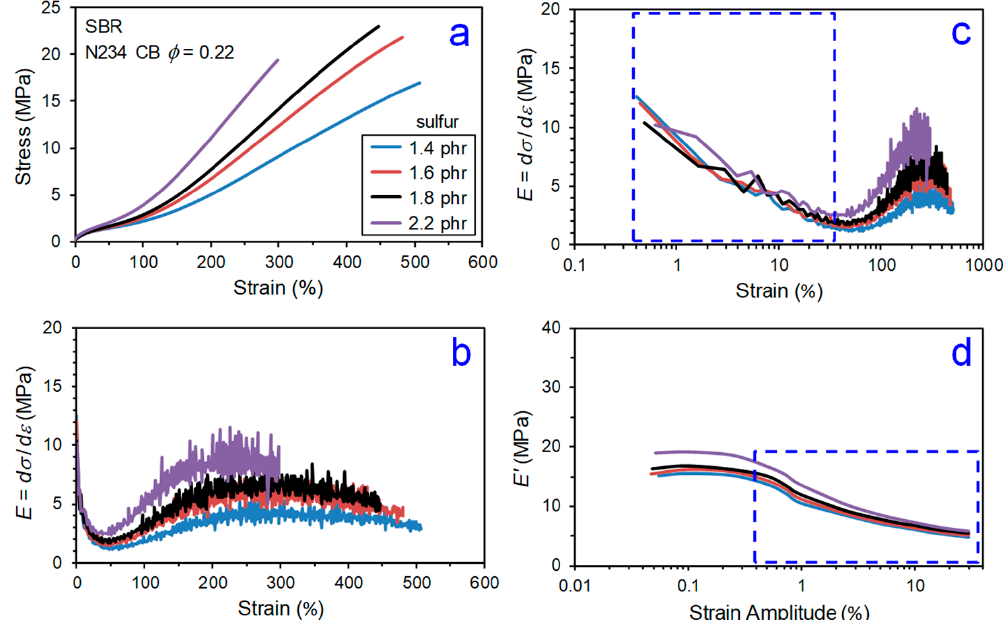
Figure 7. Effect of sulfur loading on tensile stress versus strain behavior at 23 ◦ C ( a ) and its derivative (slope; modulus ( E )) for CB-filled SBR plotted versus linear strain ( b ) and logarithmic strain ( c). Unitless strain (not %) used when determining E . Also shown is strain amplitude dependence of dynamic storage modulus ( E’ ) at 60 ◦ C and 10 Hz ( d ). Each blue dashed-line box has the same dimensions in both ( c ) and ( d ) to allow comparisons of the strain-induced softening (Payne effect). Results are replotted from Warasitthinon and Robertson [11]. Accelerator to sulfur ratio was maintained constant in this study.